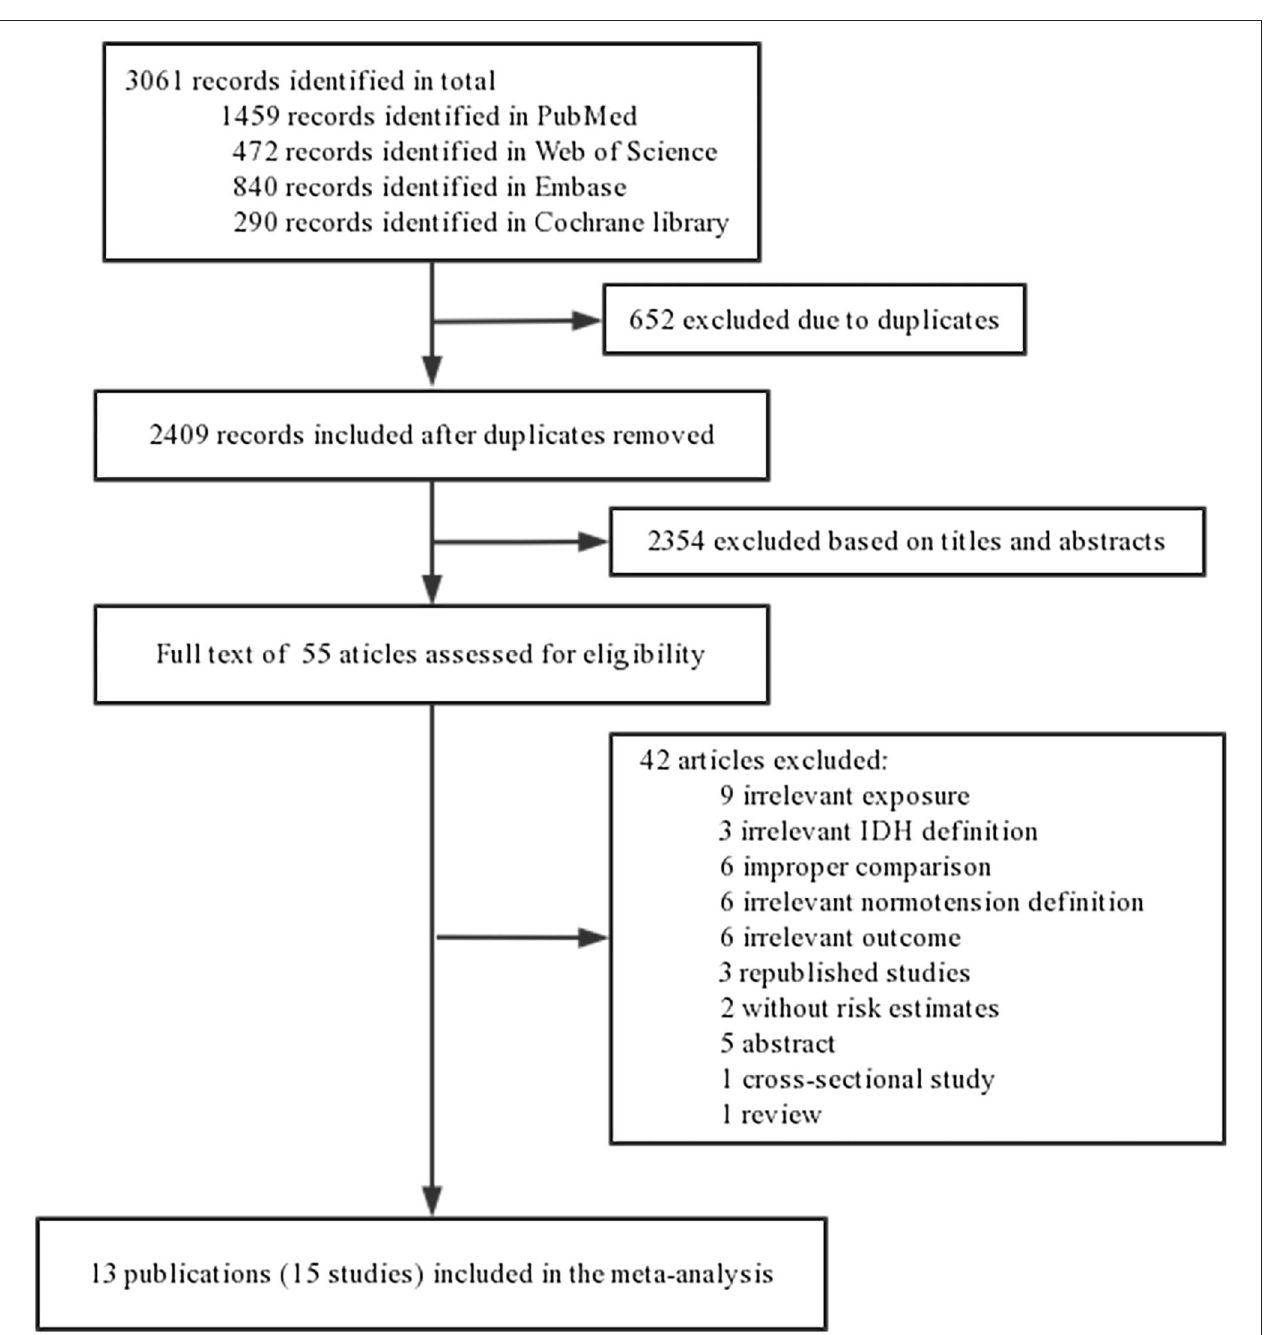
FIGURE 1 | Flowchart of literature search and study selection.